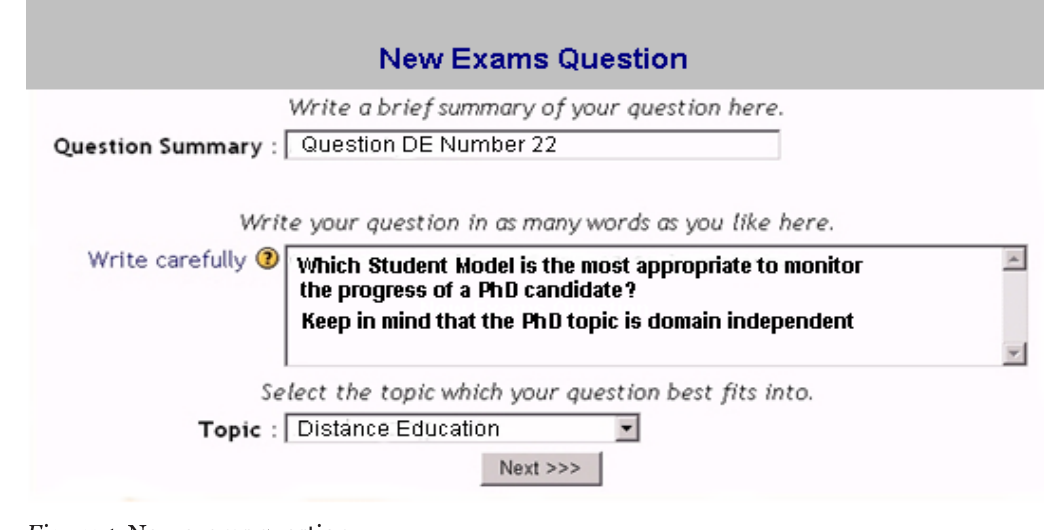
Figure 1. New exams question.